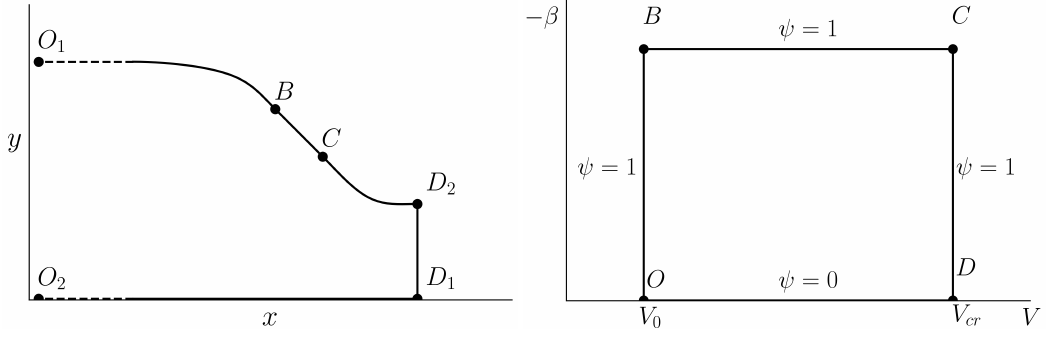
Figure 1. Hodograph transformation for the flow in the